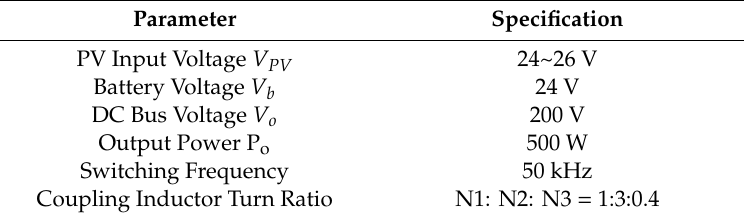
Table 3. Electrical specifications of the proposed three-port bidirectional converter.